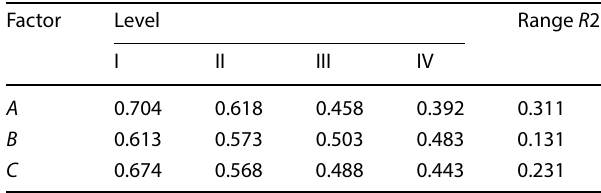
Table 4 Range analysis table for the float resonance frequency from the orthogonal test